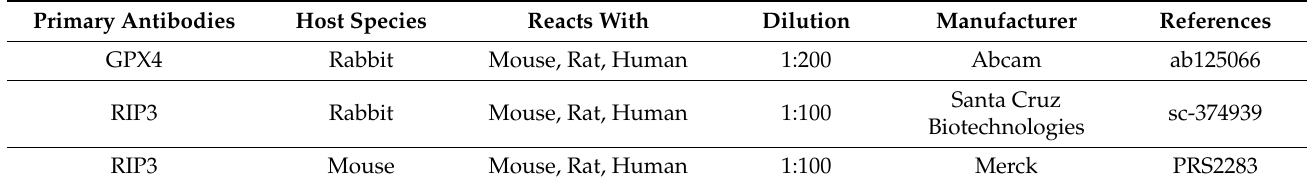
Table 2. Primary